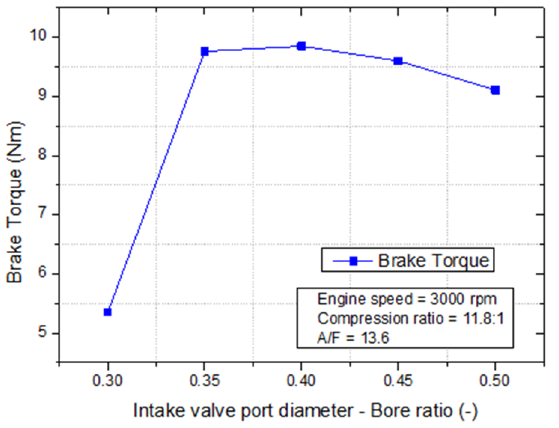
Figure 12. Brake torque versus IPD/B.